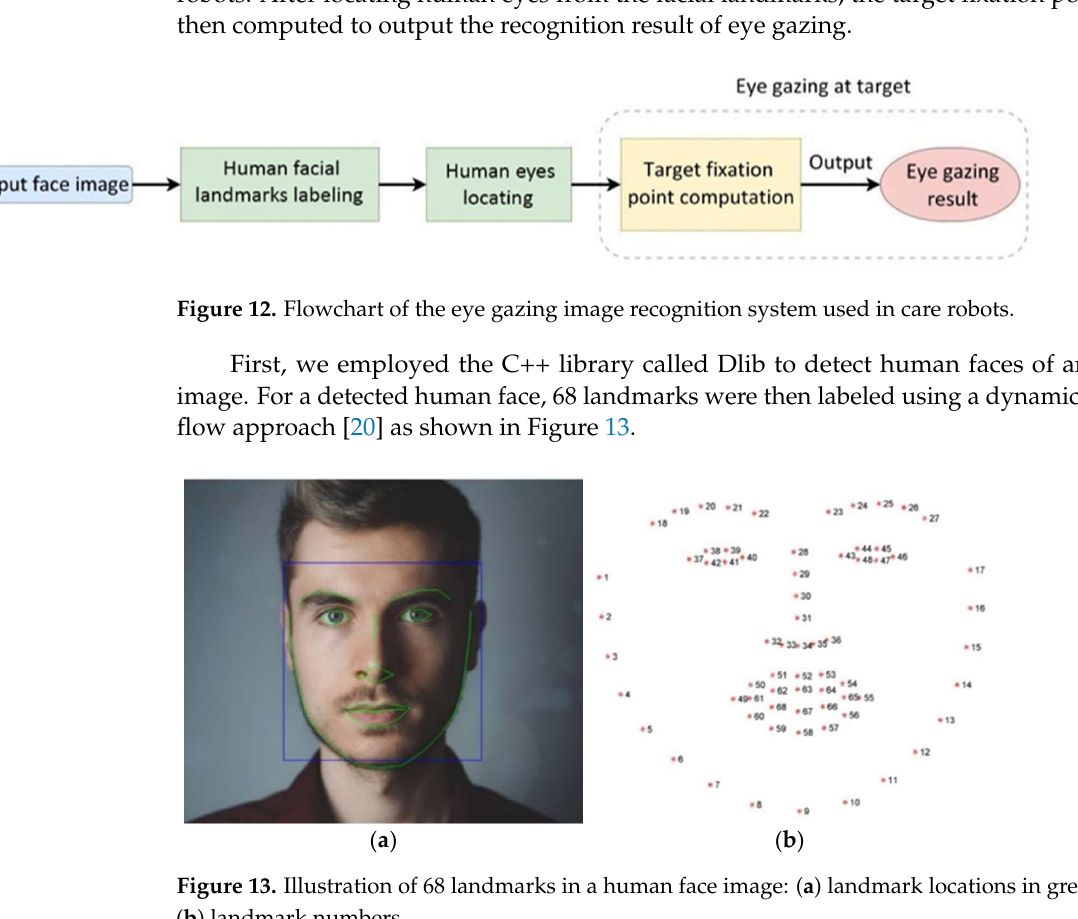
Figure 13. Illustration of 68 landmarks in a human face image: ( a ) landmark locations in green color; ( b ) landmark numbers.